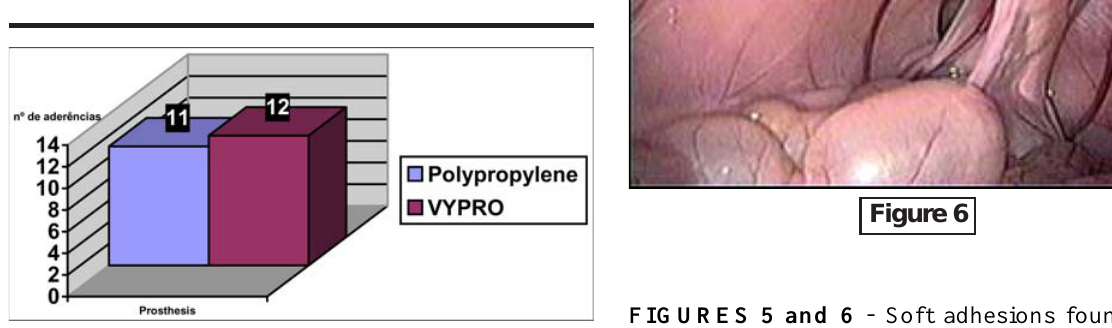
FIGURE 2 - Amount of adhesion formation to Vypro mesh fixation.